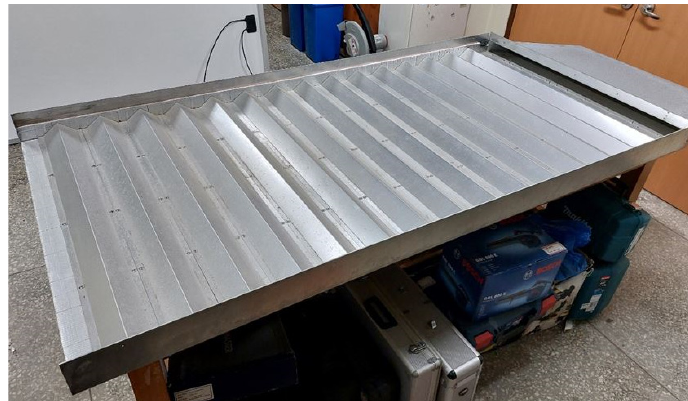
Figure 3. Actual view of a triangular block in an air duct. Table 2. Dimensions of the air duct and triangular